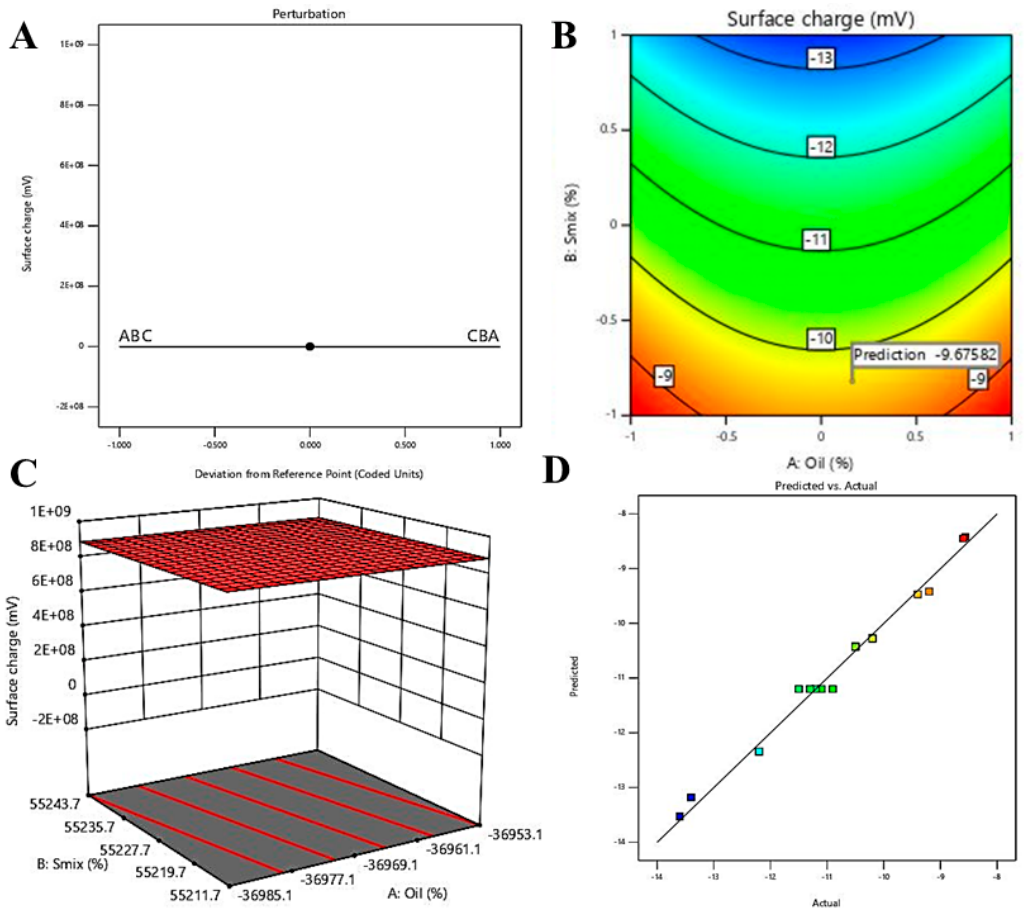
Figure 6. E ff ect of independent variables on surface charge: ( A ) perturbation graph, ( B ) contour plot, ( C ) 3D surface plot and ( D ) predicted vs. actual.